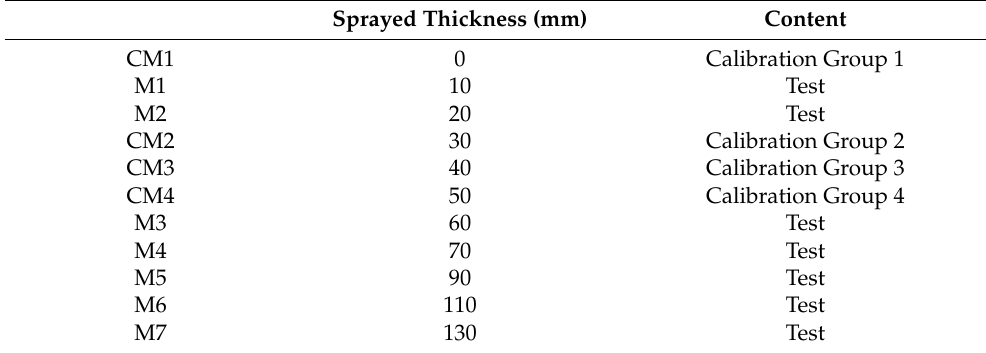
Table 9. Summary of the FE model features.